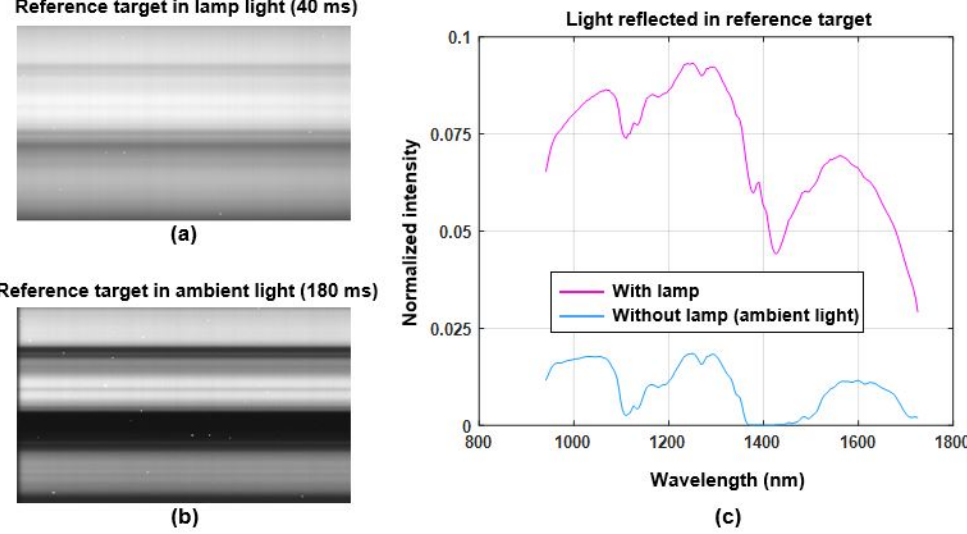
Figure 4. Light profile during experiments at HEMAB: ( a ) reflection from reference target when illuminated by halogen lamps at 40 ms exposure time, ( b ) reflection from reference target in ambient light at 180 ms exposure time, ( c ) normalized average intensity spectra of ( a , b ).